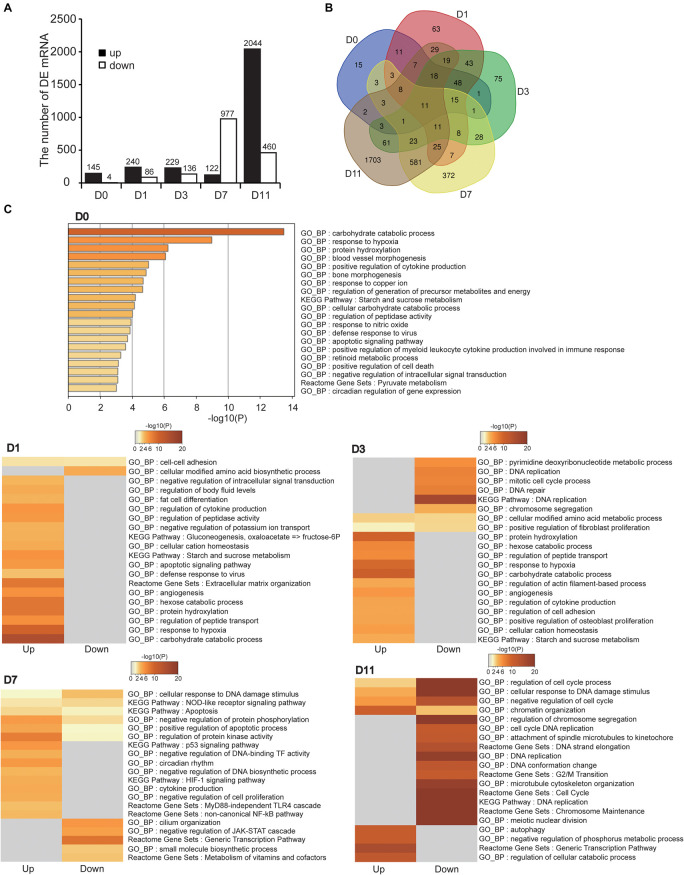
Identification and functional analysis of DE mRNAs. (A) Numbers of DE mRNAs at five timepoints of adipogenic differentiation. (B) Common and specific DE mRNAs in the five timepoints of adipogenesis showed by Venn diagram. (C) Functional enrichment analysis of DE mRNAs at the five timepoints of adipogenesis. Both upregulated and downregulated mRNAs were used in D1, D3, D7, and D11, and only upregulated mRNAs were used in D0.